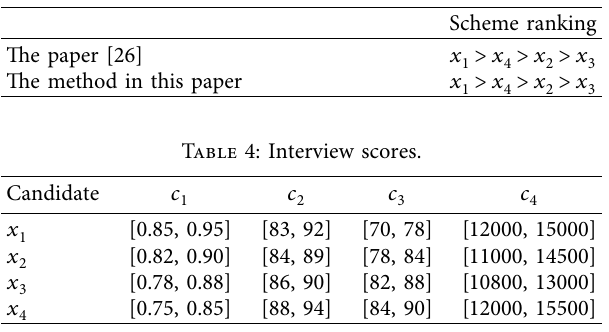
Table 3: Comparison of the results with [26].